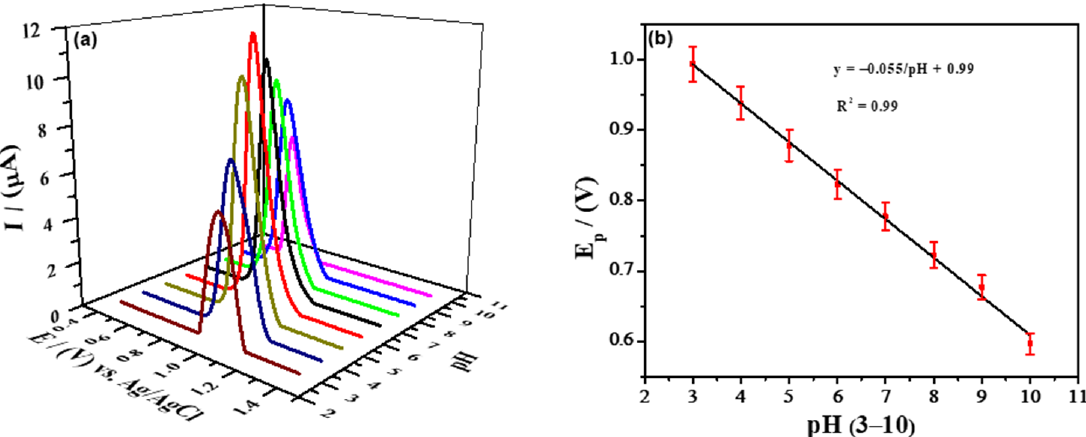
Figure 4. ( a ) SWVs showing the influence of pH on the oxidation response of NBS in PBS solution of pH 3–10 using COOH- f MWCNTs/GCE. ( b ) The plot of E p vs. pH of NBS using 0.1 M PBS as a supporting electrolyte.